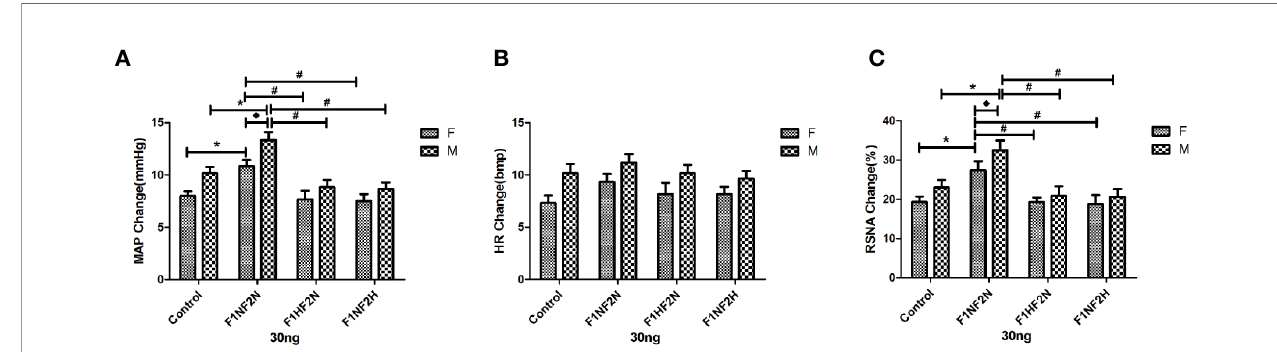
FIGURE 4 | Microinjection of Ang II 30 ng into the LVs in male and female offspring. Summary data show the peak change of Ang II (30 ng, 5 m L) microinjected into LVs on MAP (A) , HR (B) , and RSNA (C) . Data are mean ± SE ( n = 8). * P < 0.05 compared with control, # P < 0.05 compared with F 1N F 2N , and ◆ P < 0.05 male F 1N F 2N compared with female F 1N F 2N.